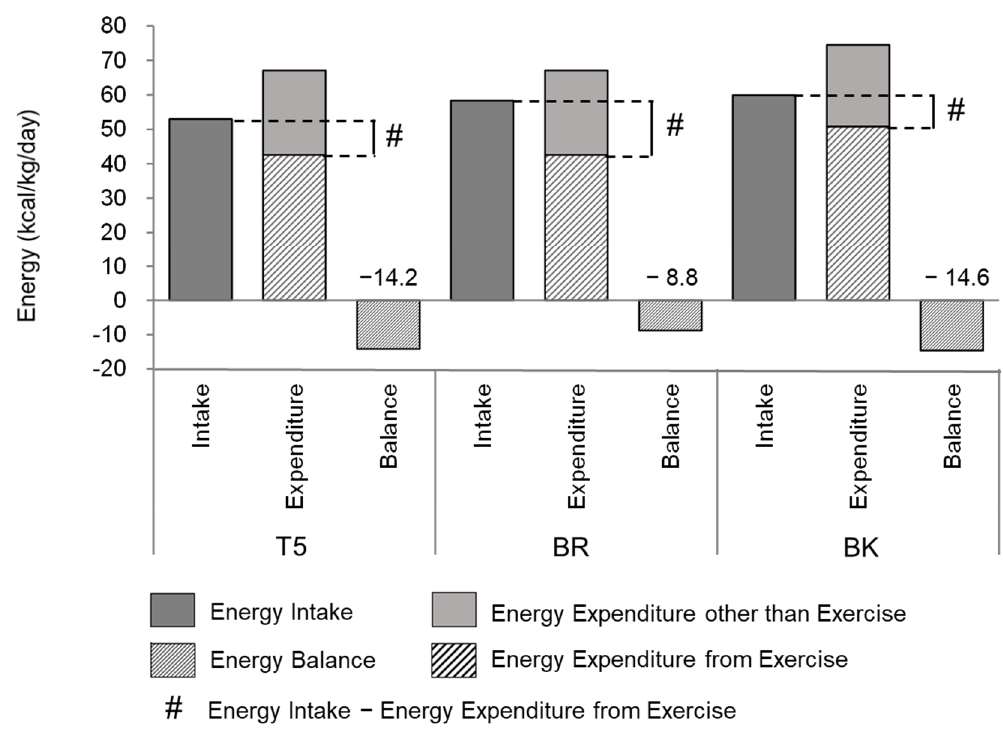
Figure 2. Energy balance during the first half of the training camp. T5, Tight-5 (numbers 1–5); BR, Back row (numbers 6–8); and BK, Backs (numbers 9–15). Energy availabilities (#) for T5, BR, and BK were 10.4, 15.8, and 9.1 kcal/kg/d, respectively.